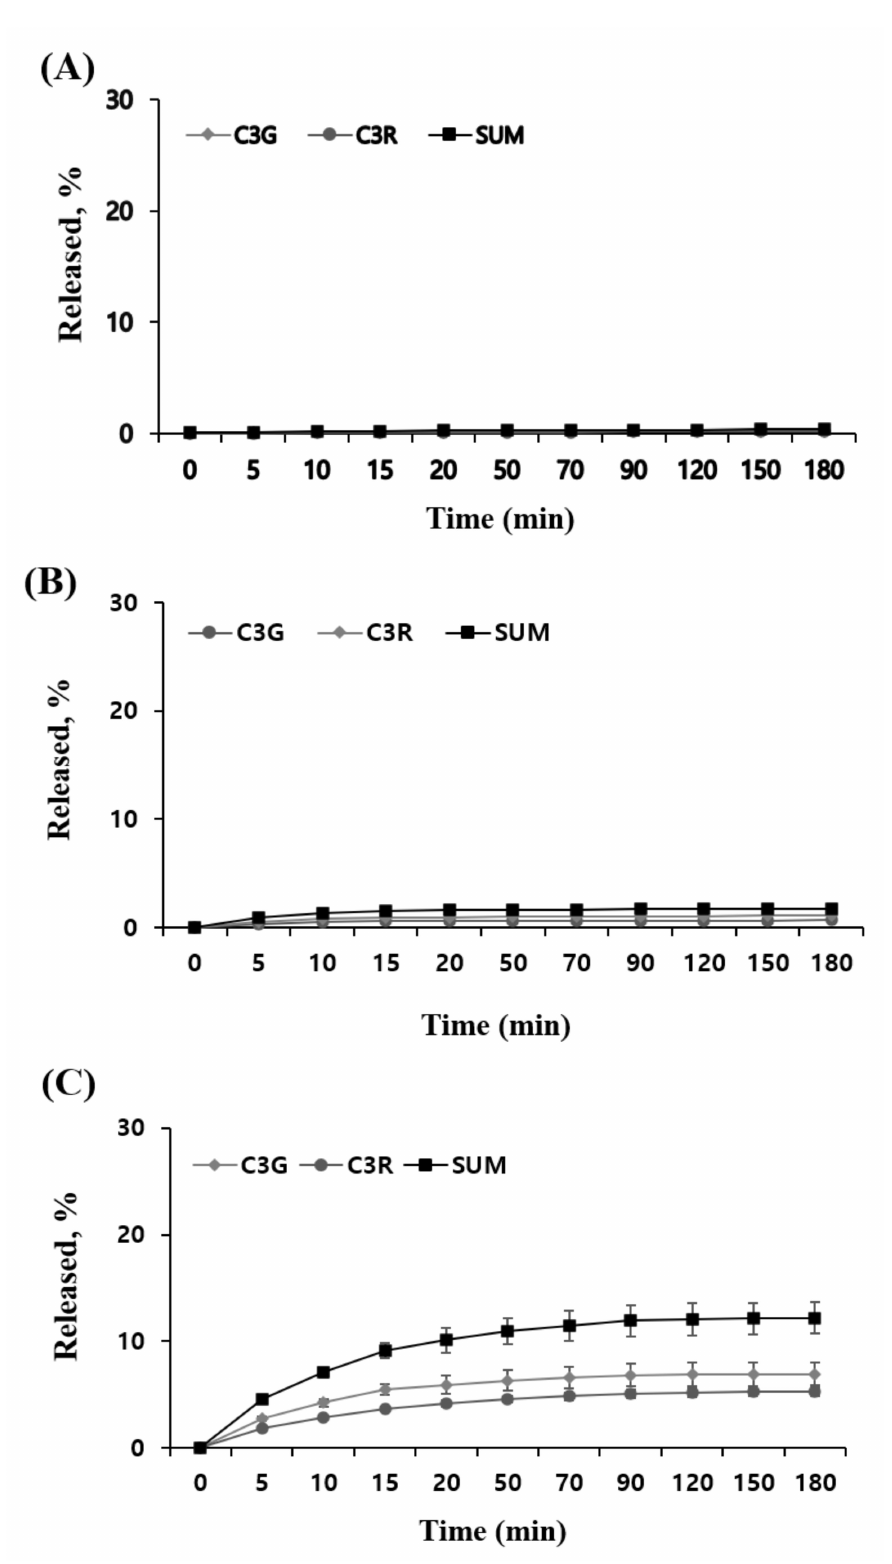
Figure 7. An in vitro release profile of C3G and C3R from ( A ) MUL, ( B ) MUL-ESFs-CA, ( C ) MUL- ESFs-CA-ALG in SIF for 2 h (n = 3, mean ±